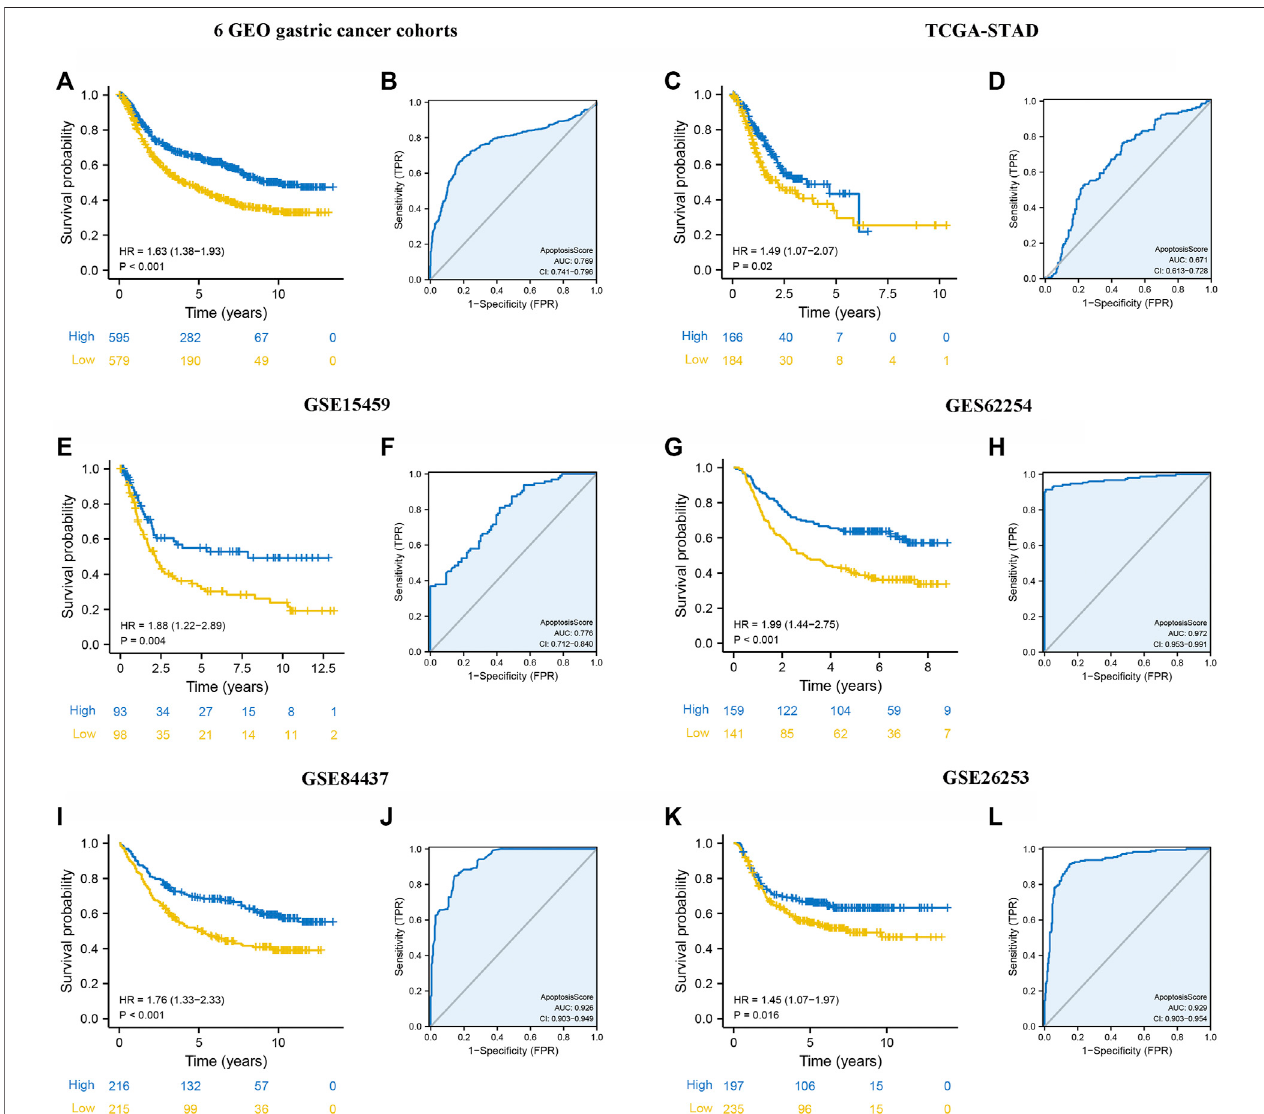
FIGURE 7 | Internal and external validation of apoptosisScore. (A) Kaplan-Meier curves for high and low apoptosisScore groups in six GEO datasets (GSE84437, GSE34942, GSE15459, GSE57303, ACRG/GSE62254, and GSE29272). (B) The predictive value of apoptosisScore in six GEO dataset. (C) Kaplan-Meier curves for high and low apoptosisScore groups in TCGA-STAD. (D) The predictive value of apoptosisScore in TCGA-STAD. (E) Kaplan-Meier curves for high and low apoptosisScore groups in GSE15459. (F) The predictive value ofapoptosisScore in GSE15459. (G) Kaplan-Meier curves forhigh and low apoptosisScoregroups in GSE62254. (H) The predictive value of apoptosisScore in GSE62254. (I) Kaplan-Meier curves for high and low apoptosisScore patient groups in GSE84437. (J) The predictivevalueofapoptosisScoreinGSE84437. (K) Relapse-freesurvivalanalysisofapoptosisScoreinGSE26253cohort. (L) ThepredictivevalueofapoptosisScorein